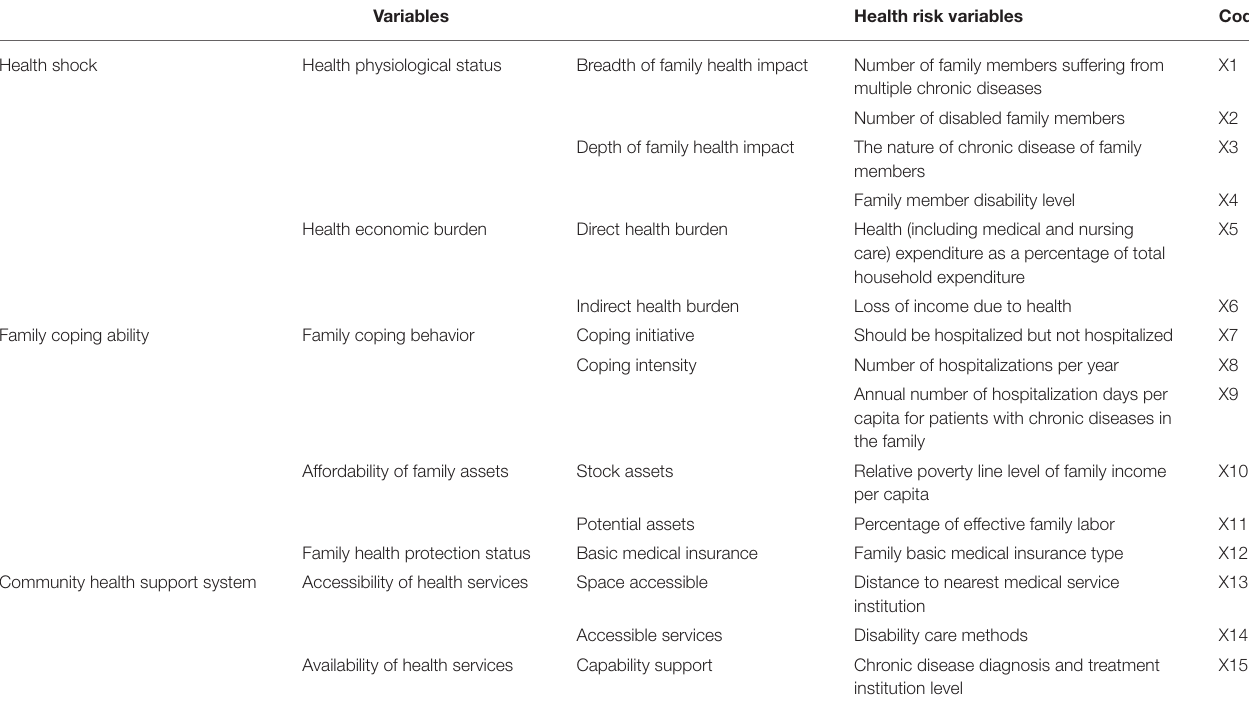
TABLE 1 | Health risk indicators and codes